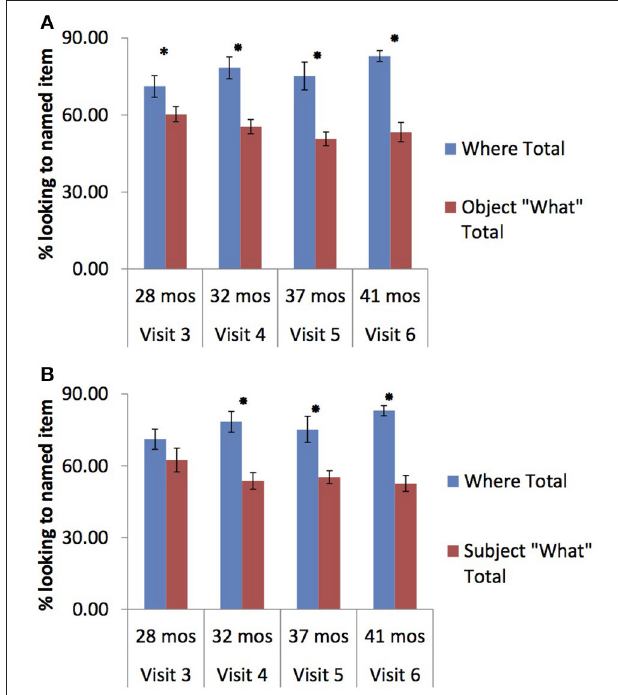
FIGURE 1 | (A) Comparism of where vs. object trails for TD Children across visits. * p < 0.05. (B) Comparism of where vs. subject trails for TD Children across visits. * p <